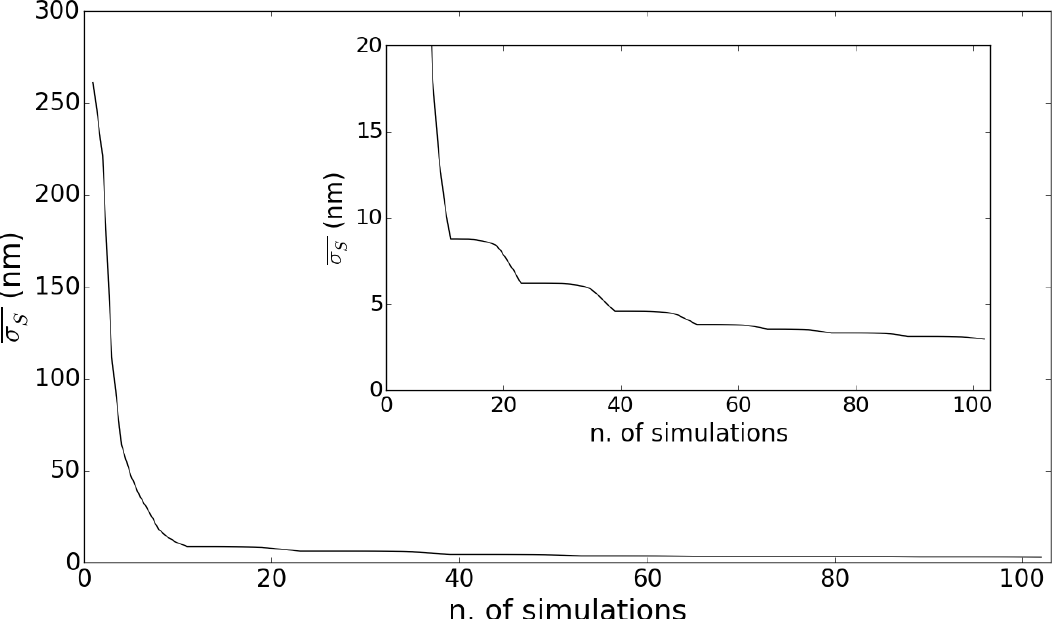
Figure 6. Plot of the mean error on the determination of the OT position ( σ ) as a function S of the number of simulations used to determine the γ coefficients. The inset focuses on the i relevant range of values for σ and shows that it actually reaches the nanometer S